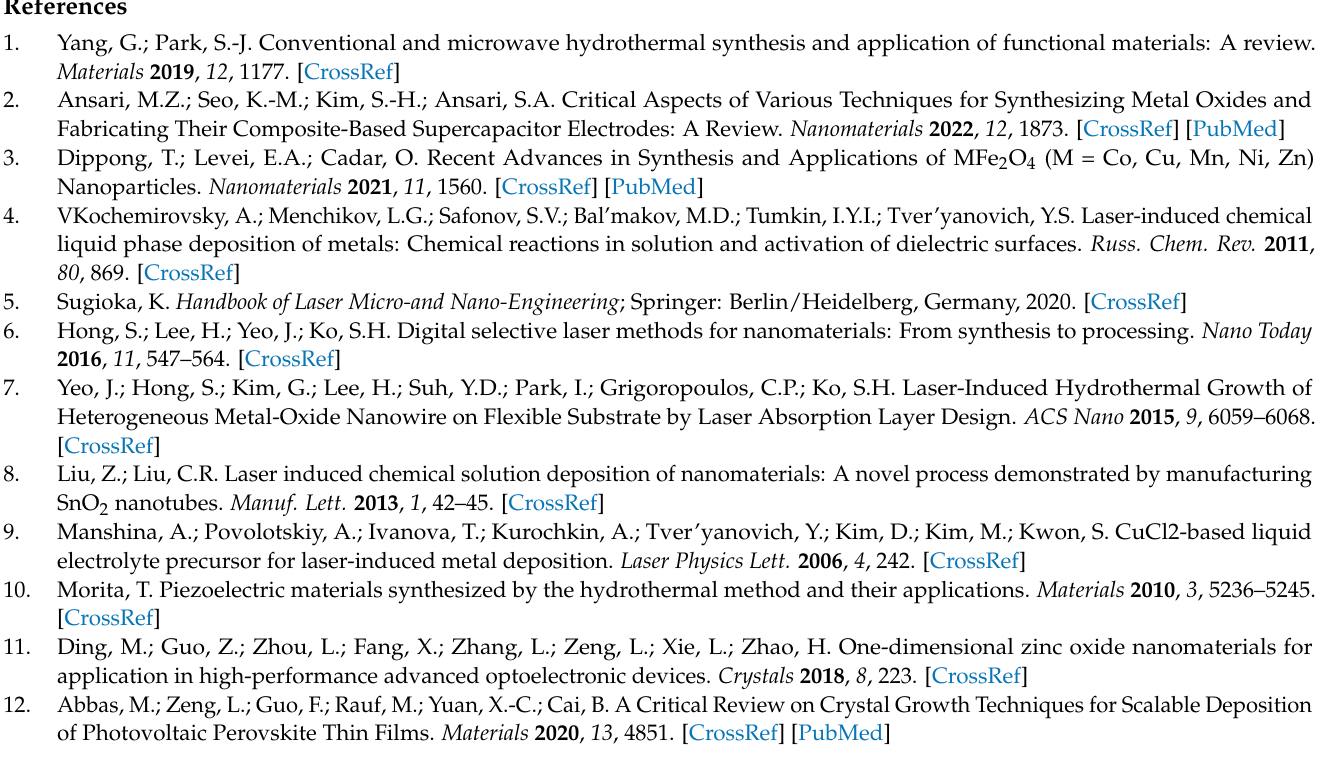
concentration distribution of C(aq) under different conditions; Figure S4: the diagram of Morphology under different conditions; Figure S5: The temperature distribution under different conditions; Figure S6: Streamlines and Velocity Contours under different conditions. Table S1: Physical and Chemical Parameters; Table S2: The condition name and its detailed parameters; Table S3: Sediment morphology parameter values under different